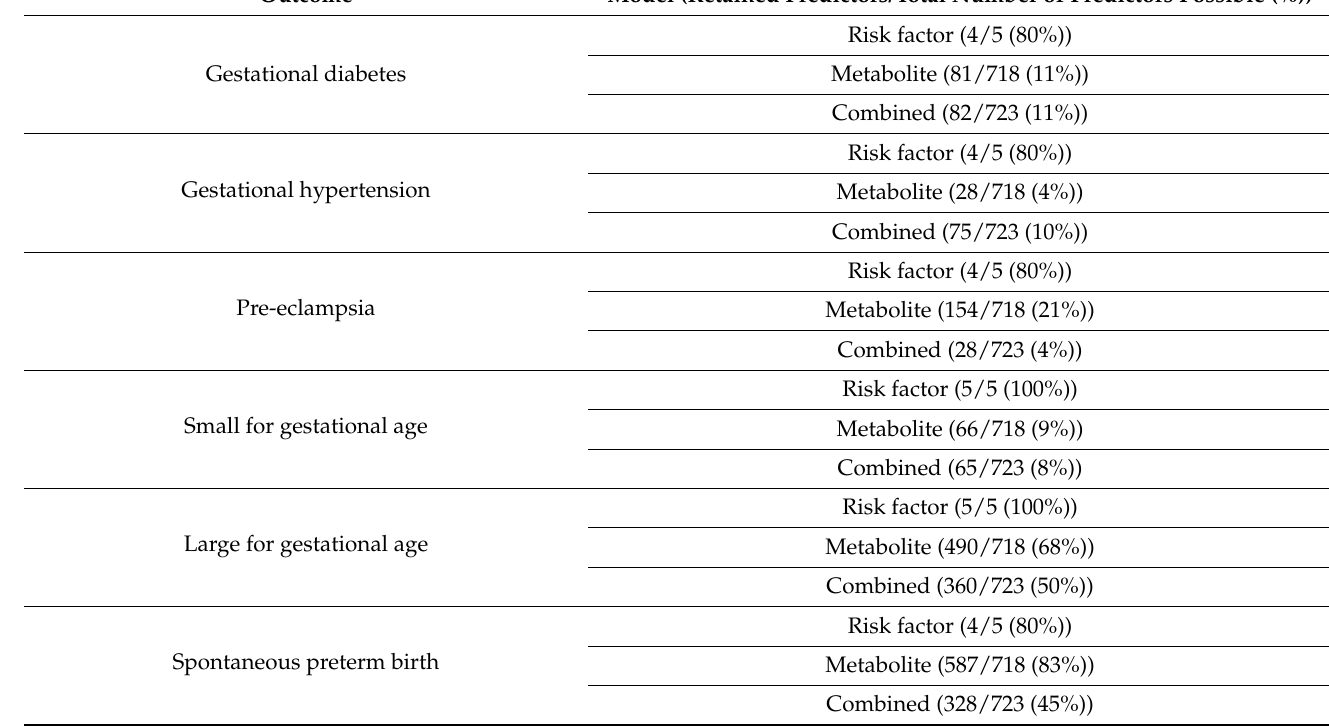
Table 2. Number of predictors retained in each model developed and tested in BiB 2000 from total possible ( n (%)). Percentages are rounded to the nearest whole